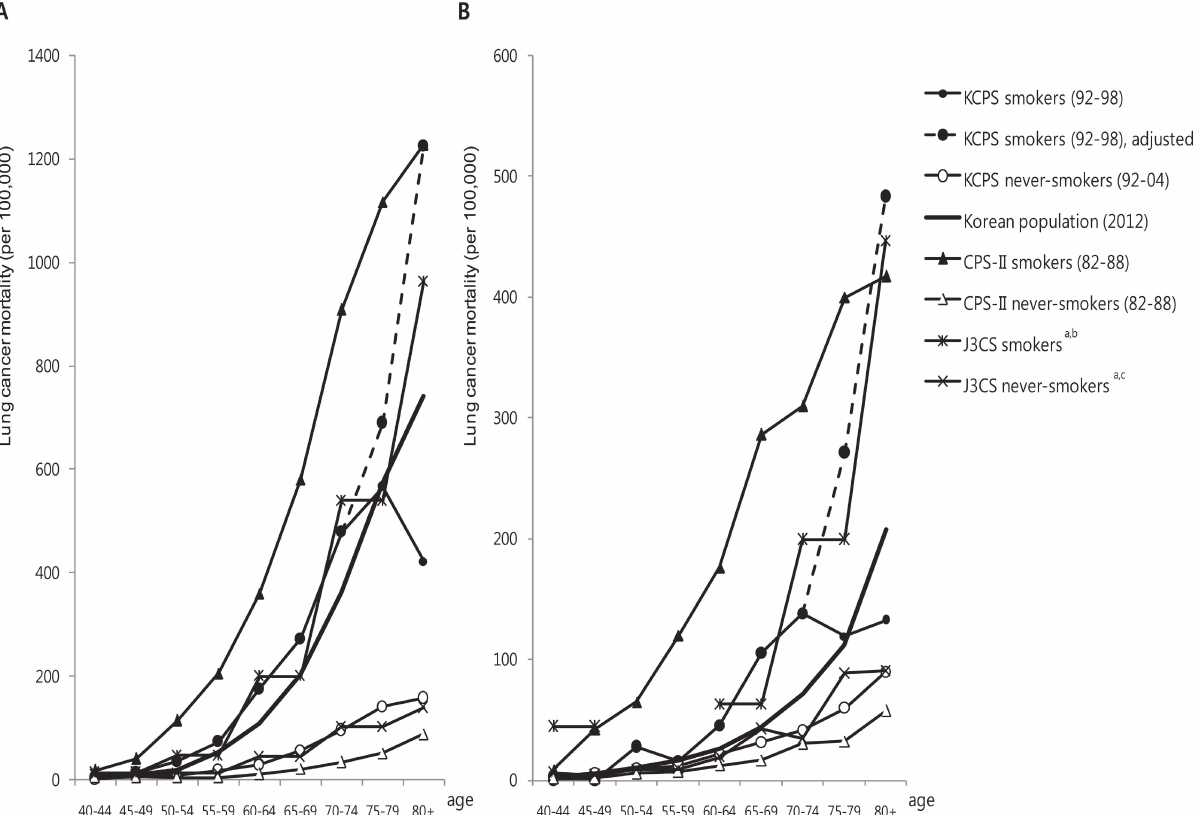
Figure. Lung cancer mortality rates of smokers and non-smokers in the Korean Cancer Prevention Study (KCPS), Cancer Prevention Study-II (CPS-II), three large-scale cohort studies in Japan (J3CS), and the general Korean population. A, lung cancer mortality rates among males; B, lung cancer mortality rates among females, from the KCPS, CPS- II, and J3CS a,b,c and the general Korean population in 2012. a Lung cancer mortality rates among men in the pooled analysis of the three large-scale cohort studies in Japan. 20 b Smokers ’ lung cancer mortality rates among women are depicted with values approximated from the graph of the three-prefecture cohort study. 19 c Never-smokers ’ lung cancer mortality rates among women in the three-prefecture cohort study.